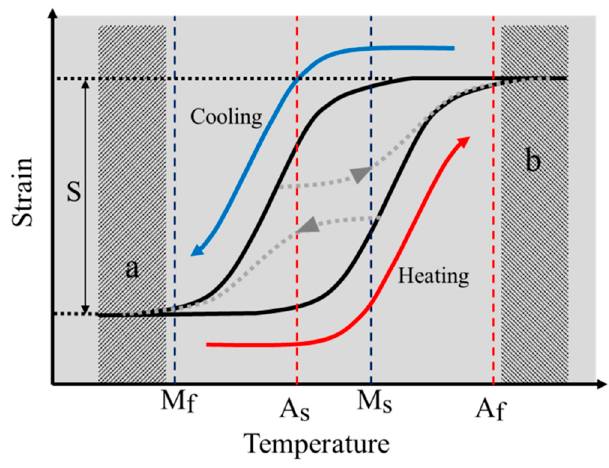
Figure 6. Input signal description.